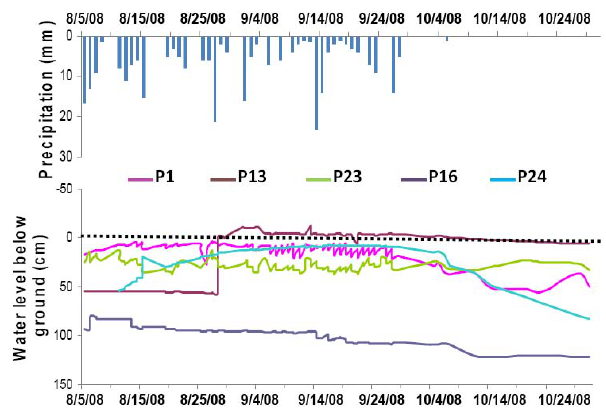
Fig. 4. Water table elevations for selected wells in and around the active gully section. Precipitation during the period is also shown.